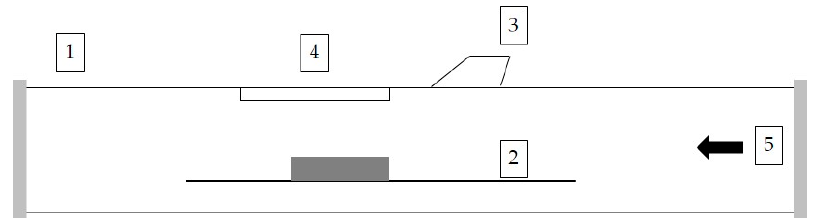
Figure 2. Schematic illustration: 1—test track, 2—test sample, 3—injection system, 4—monitoring window, 5—mass flow direction.